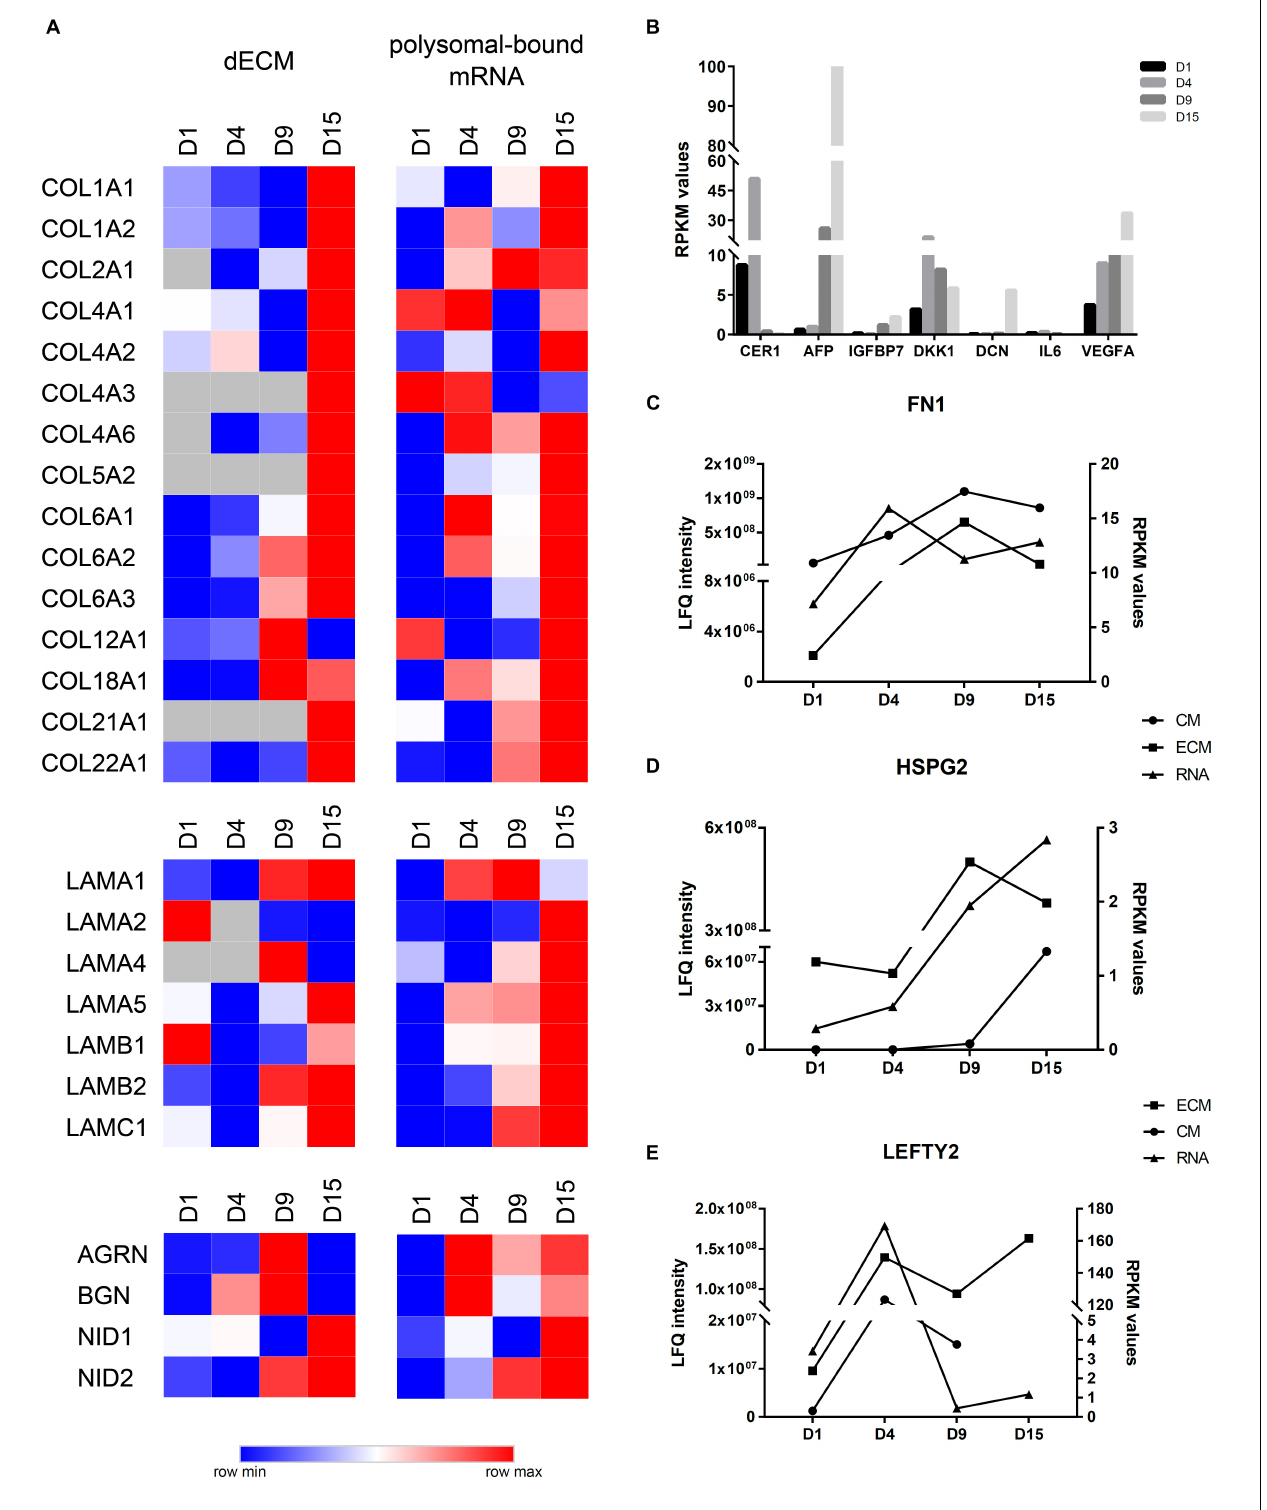
FIGURE 5 | Comparison of ECM and CM results with polysomal mRNA sequencing data. (A) Heatmap visualization of log2 LFQ intensities (ECM) or log2RPKM values (RNA) of selected proteins/genes during cardiomyogenic differentiation of hESCs. Higher log2 values are represented in red, and the lower log2 values are represented in blue. (B) RPKM values of polysomal mRNA data of selected genes identified at CMs. (C) Comparison of LFQ intensities of fibronectin (FN1), (D) perlecan (HSPG2), and (E) LEFTY2 identified at ECM and CM with RPKM values of polysomal mRNA data.